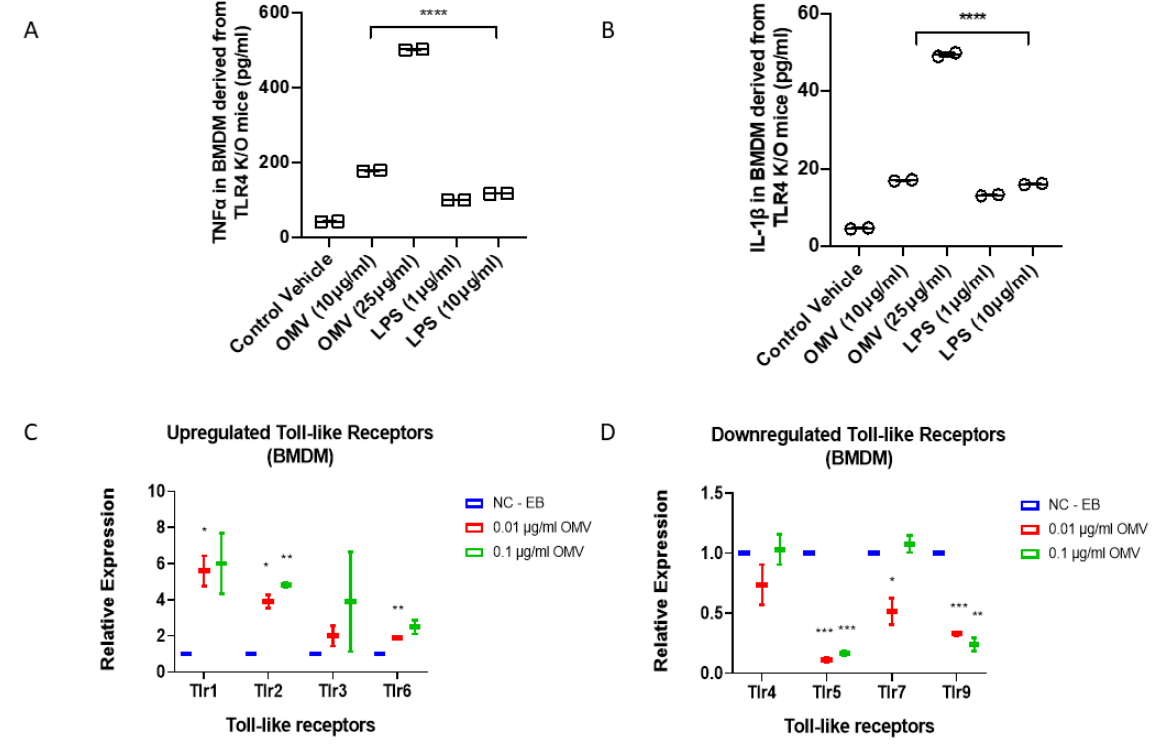
Figure 5. OMVs induce macrophage activation via multi-signaling pathways. ( A , B ) BMDMs were obtained from TLR4 knockout mice and then treated with OMVs (10 – 25 µg/mL) or LPS (1 – 10 µg/mL). After 24 h, TNF- α ( A ) and IL- 1β ( B ) levels in the cell culture supernatant were determined using ELISA. Results are presented using mean ± SD from at least two independent experiments (* p ≤ 0.01). ( C , D ) BMDMs were treated with OMVs in the dose as indicated. After 24 h, mouse inflammation and autoimmune arrays were used to screen for the candidates involved in OMV-stimulated inflammatory responses. The upregulated genes were shown in ( C ) and downregulated genes were shown in ( D ). Control groups were normalized to “1” and folds of increase/decrease were presented for the indicated candidates. Data points were analyzed using two-tailed unpaired Student’s t -test to compare with LPS treated or EB treated group; Mean ( n = 2) ± SD; * p ≤ 0.005 ** p ≤ 0.001, *** p ≤ 0.0005, **** p ≤ 0.001 vs. the control (EB treated) or 10 µg LPS treatment group.